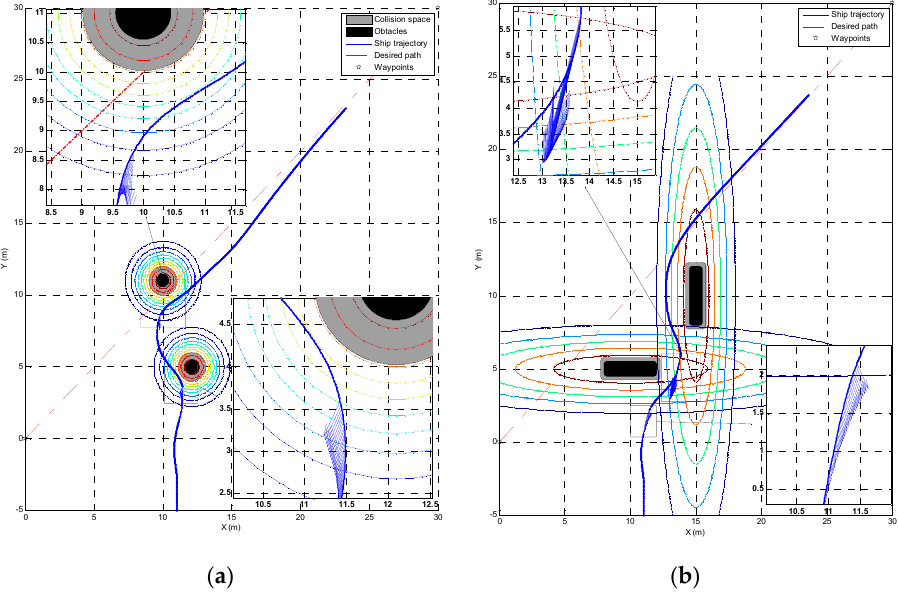
Figure 13. Path-following simulation with multi static obstacles: ( a ) round obstacles; and ( b ) rectan- gular obstacles. Table 2. The computational cost and path length in the simulations with multi static obstacles.